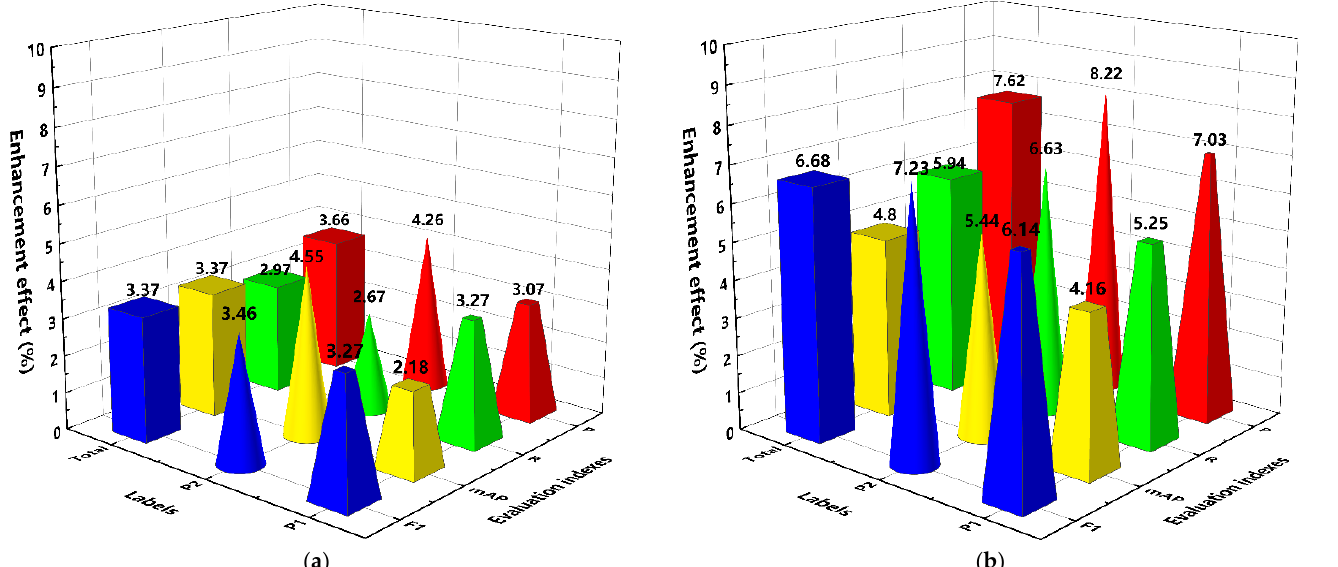
Figure 8. Data augmentation testing result comparisons: ( a ) YOLOv3 model; ( b ) proposed model.